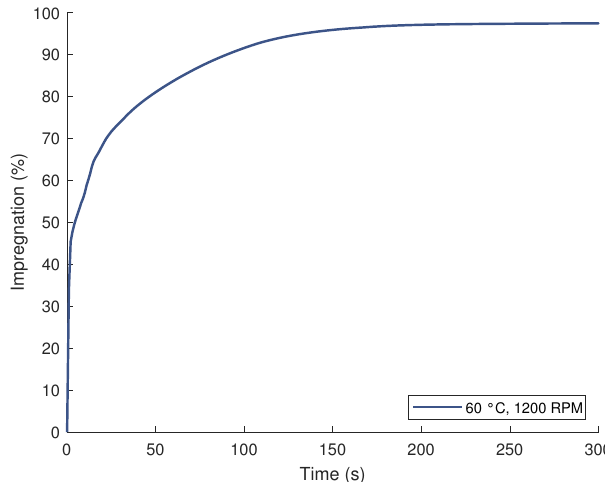
Figure 14. Impregnation progress over